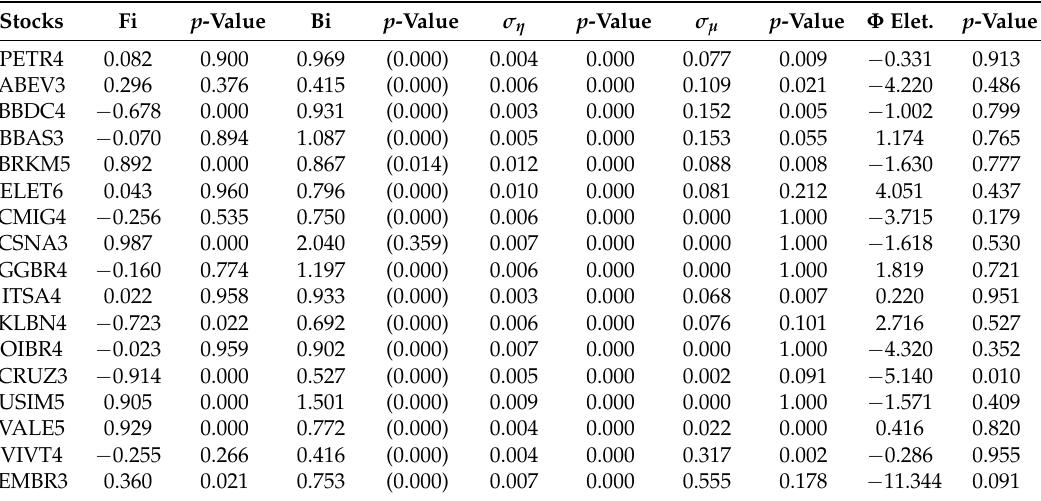
Table A5. Coefficients of the model with electricity consumption.